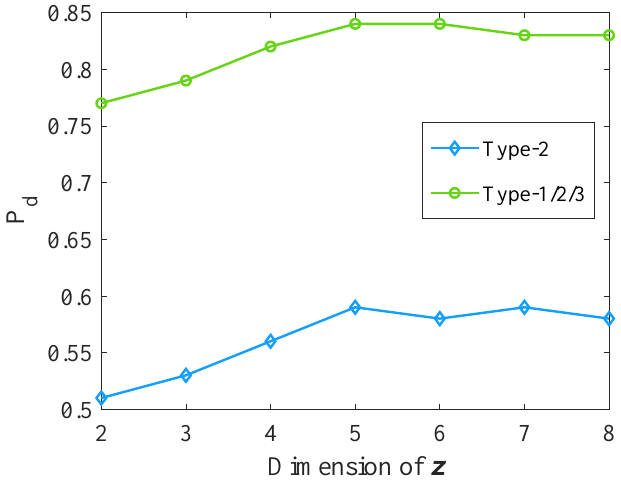
Figure 13. The P d results of GM-CVAE by varying hyper-parameters z